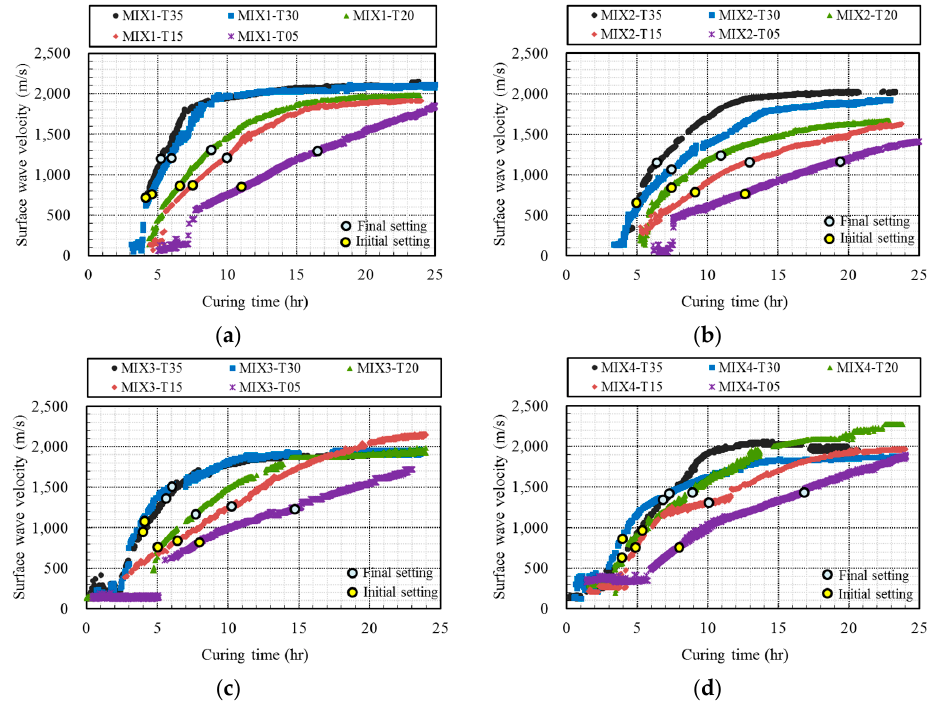
Figure 8. Surface wave velocities with the initial and final setting times: ( a ) MIX1, ( b ) MIX2, ( c ) MIX3, and ( d ) MIX4. Table 3. Initial and final setting times determined by the penetration resistance test for 20 concrete specimens.